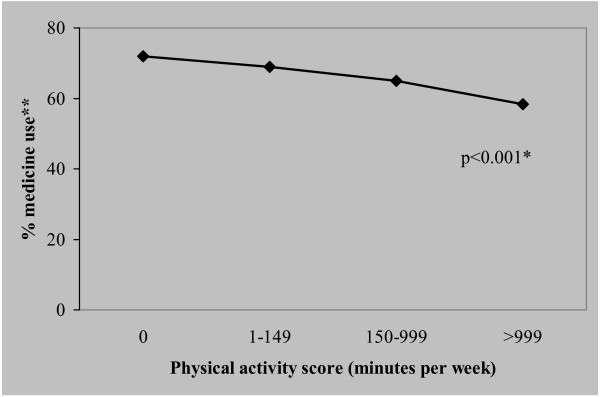
Prevalence of medicine use in the 15 days prior to the interview according to physical activity categories. Pelotas, Brazil, 2002. * Wald test for trend. ** Percentage of any medicine use in the 15 days prior to the interview.